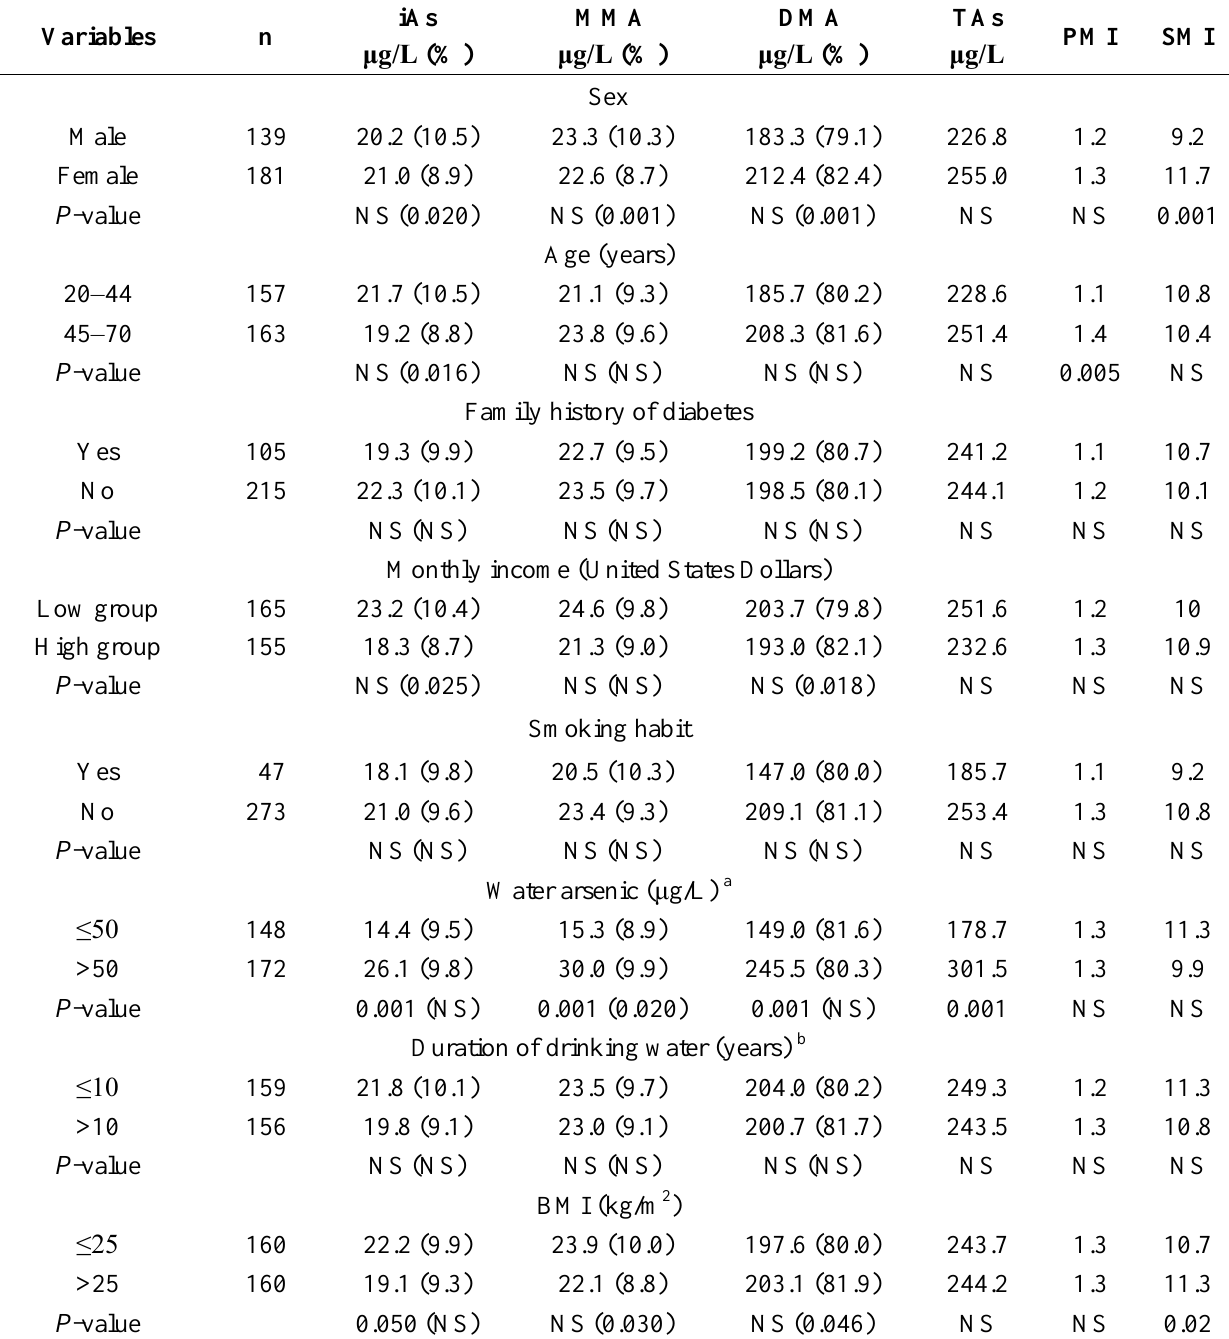
Table 2. Comparison of urinary arsenic profiles in absolute values and percentages between subgroups, Faridpur, Bangladesh,